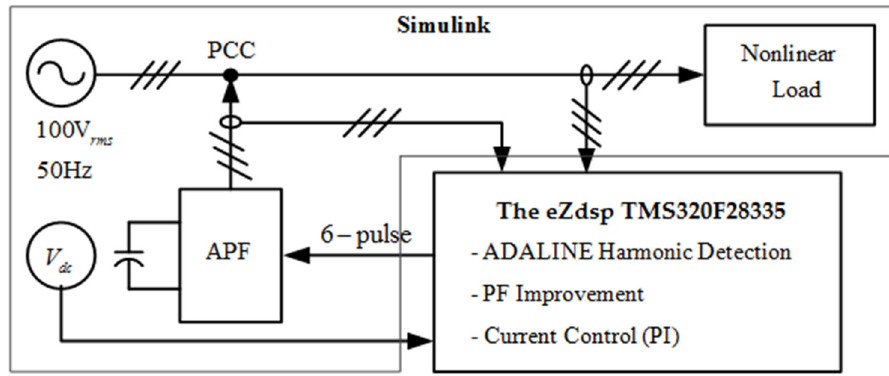
Figure 6. The diagram of shunt active power filter (SAPF) implementation using hardware-in-loop (HIL).